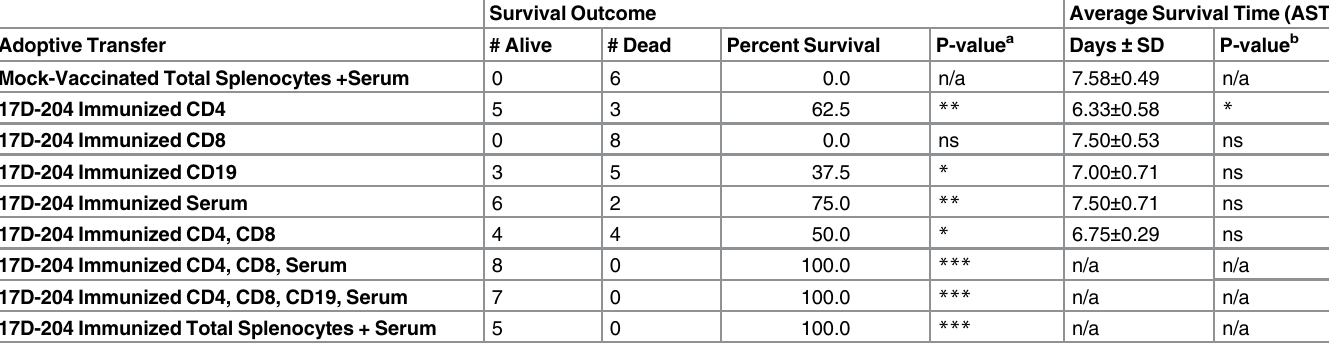
a p values were calculated using a one-tailed chi-squared test compared to mock. ns, not signi fi cant; * , p (cid:1) 0.05; ** , p (cid:1) 0.005; *** , p (cid:1) 0.0005. b p values were calculated using a one-way ANOVA with Tukey's multiple comparisons test compared to mock. ns, not signi fi cant; * , p (cid:1)